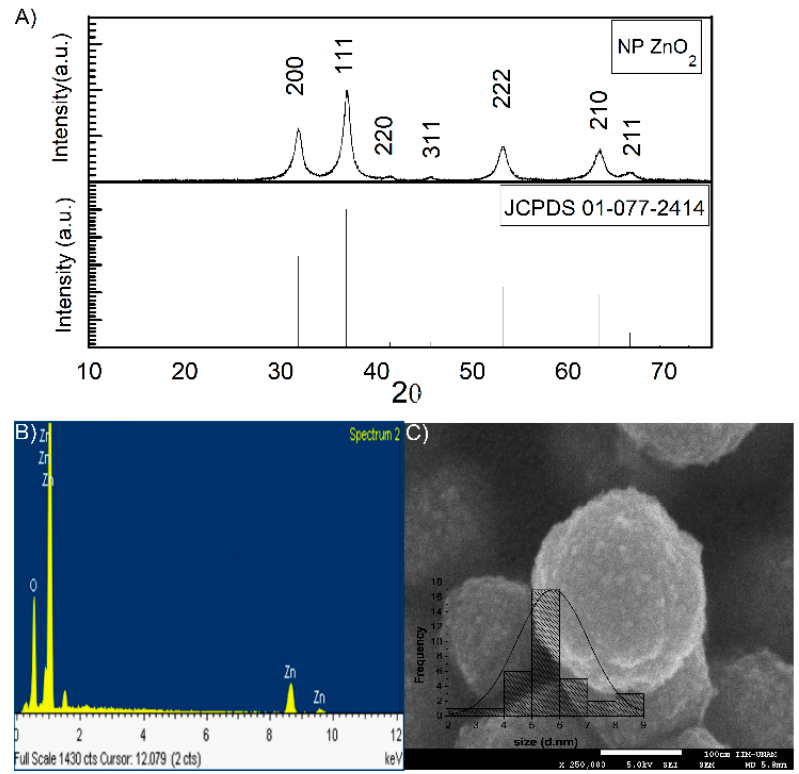
Figure 3. ( A ) X-ray diffraction (XRD), ( B ) Energy Dispersive X-ray spectroscopy (EDX) and ( C ) Scanning Electronic Microscope (SEM) image of ZnO 2 nanoparticles. The insert in the SEM image corresponds to a size distribution histogram of the ~8 nm crystals constituting a ~100 nm in diameter particle.